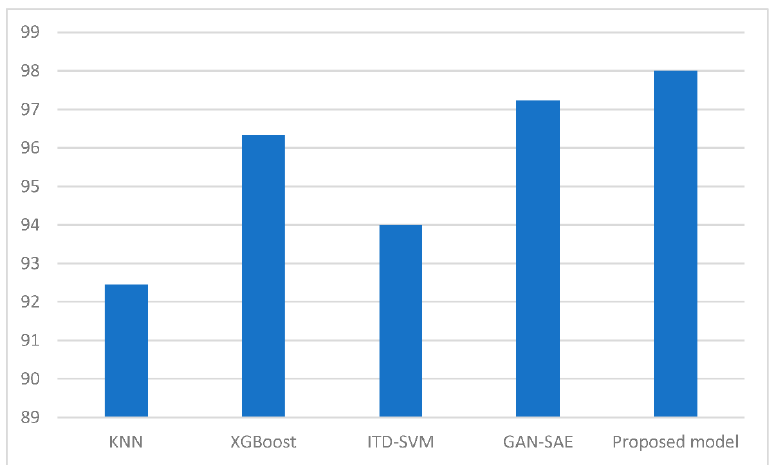
Figure 11. Comparison of Precision and Recall of some state-of-the-art techniques.